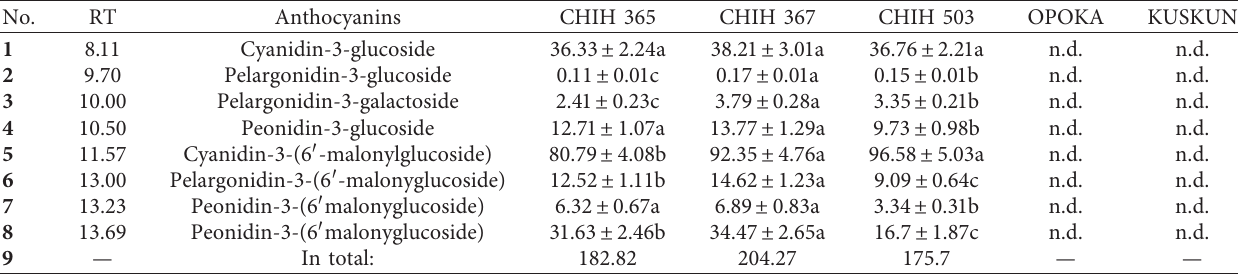
Table 3: Profile of polyphenolic compounds—anthocyanins—in the tested maize varieties (mg/kg of dry matter). No.